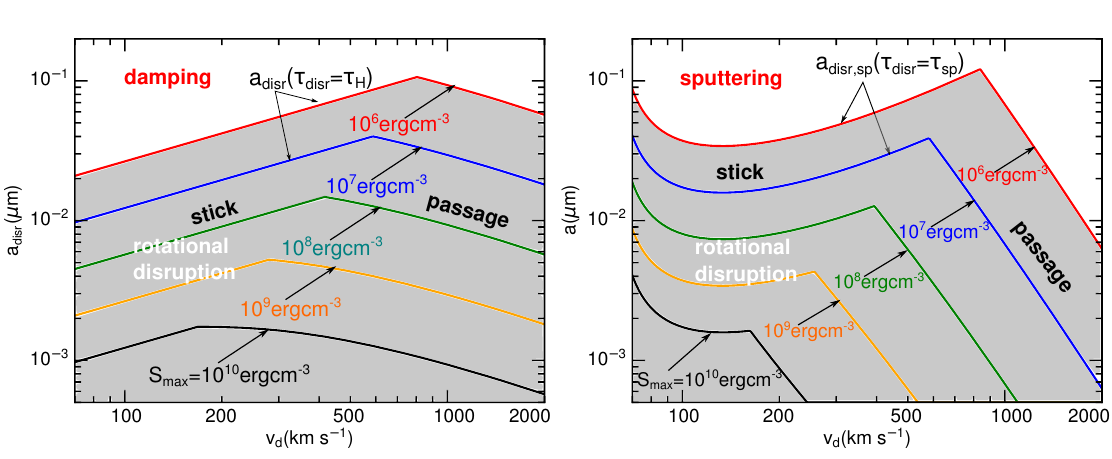
Figure 11. Grain disruption size vs. grain velocity assuming the different tensile strength of grain material. The solid lines mark the boundary between rotational disruption and damping ( τ disr = τ H ) and τ disr = τ sp (right panel). Shaded areas mark the parameter space where rotational disruption (METD) is faster than rotational damping (left panel) and nonthermal sputtering (right panel). From Hoang and Lee